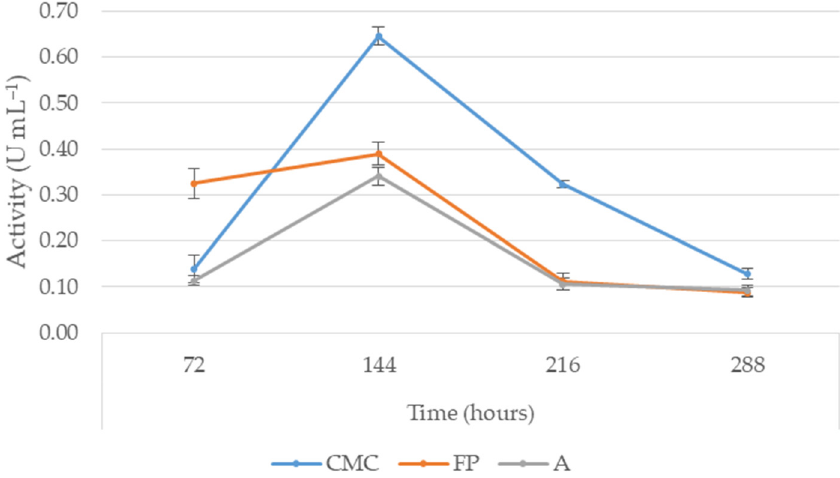
Figure 3. FPase production of Bacillus sp. 8E1A with various sources of cellulose. Previously, Avicel cellulose has already been recognized as a substrate in the broth to increase FPase production by spore-forming bacteria. Mihajlovski et al. [26] observed a slightly higher FPase production in the Avicel broth (approximately 0.2 U mL − 1 ) compared to the cell-free supernatant from broth with CMC (approximately 0.1 U mL − 1 ) in P.